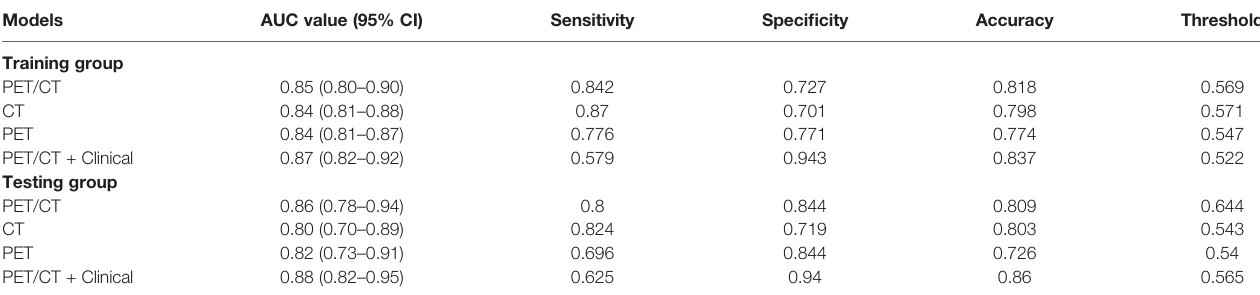
TABLE 2 | The performance of radiomic models in training and testing groups. Models